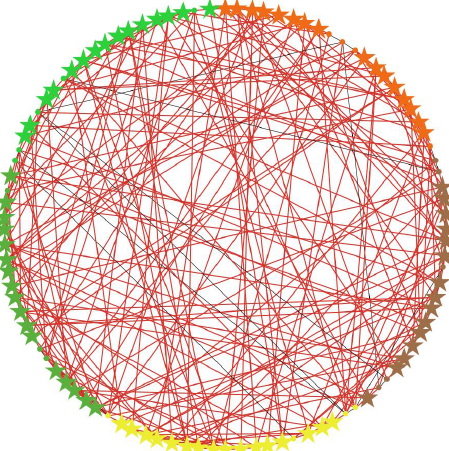
Figure 8: Snapshot of multi-strain global epidemic on modified WS network with five node types of di ff erent colors. The stars are infected nodes and the red edges are adjacent to infected